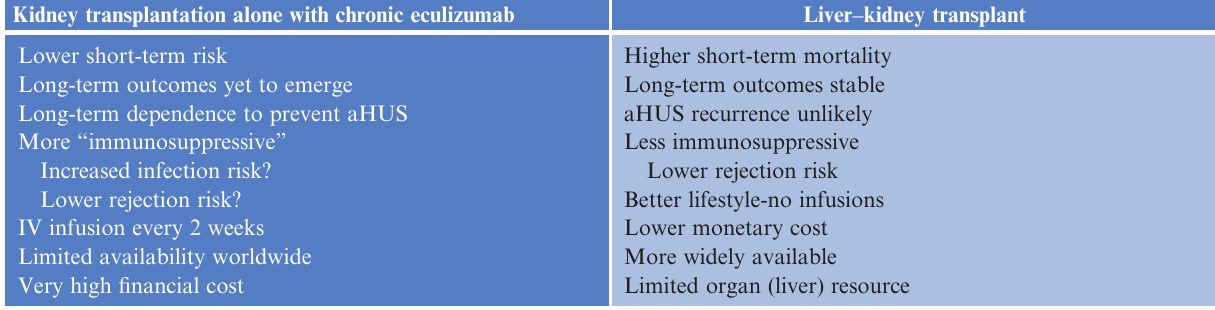
Table 4. Comparison of transplant approaches in aHUS Kidney transplantation alone with chronic eculizumab Liver – kidney transplant Lower short-term risk Long-term outcomes yet to